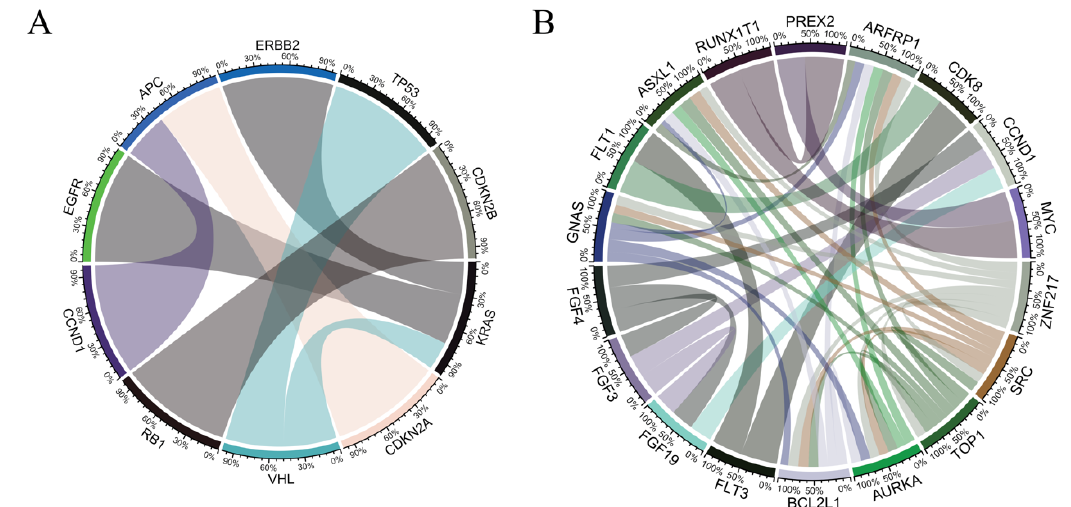
Figure 2. Mutually exclusive and co-occurring genes. Genes with more than 35 positive mutation cases were considered. Chord diagrams of ( A ) mutually exclusive, and ( B ) co-occurring gene pairs with a false discovery rate (FDR) less than 0.01. The arcs shown in the scaled chord-diagram between the pairs of genes represent the mutual exclusivity or co-occurrence. There were seven mutually exclusive gene pairs, of which KRAS was mutually exclusive with EGFR, ERBB2, and VHL. APC was mutually exclusive with CCND1 and CDKN2A. Thirty-one co-occurring gene pairs with more than one co-occurring gene pair were identified. ARFRP1, ASXL1, AURKA, BCL2L1, GNAS, SRC, TOP1, ZNF217 were most commonly co-occurring, and each co-occurred with seven other genes (FDR < 0.01).